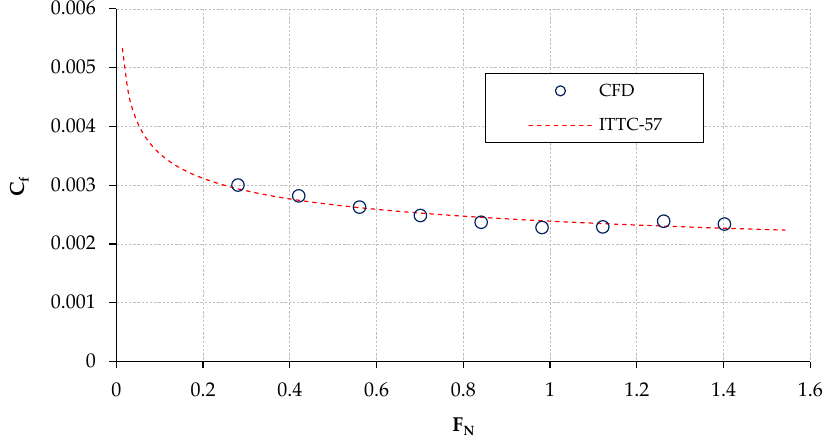
Figure 5. Skin friction coefficient of the reference demihull.